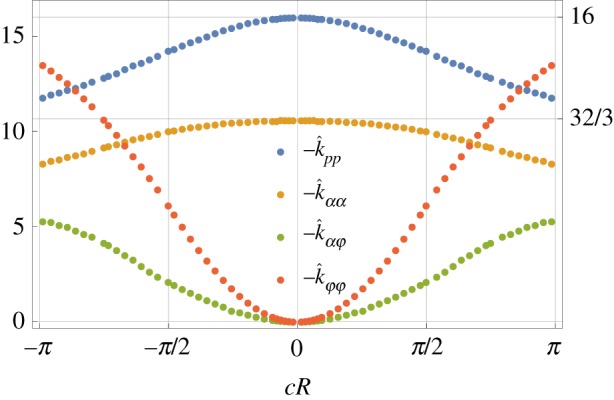
Coefficients of hydrodynamic resistance (3.13) as functions of the curvature c of a circular shell; k^φφ=μR3kφφ is the dimensionless form of the drag (3.15).